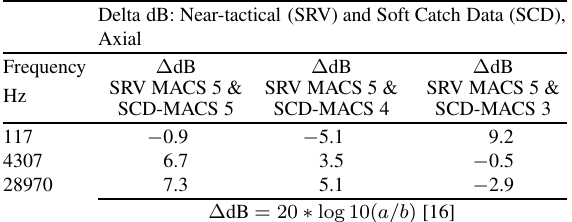
Table 3 Difference in dB’s between shot series, axial accelerations